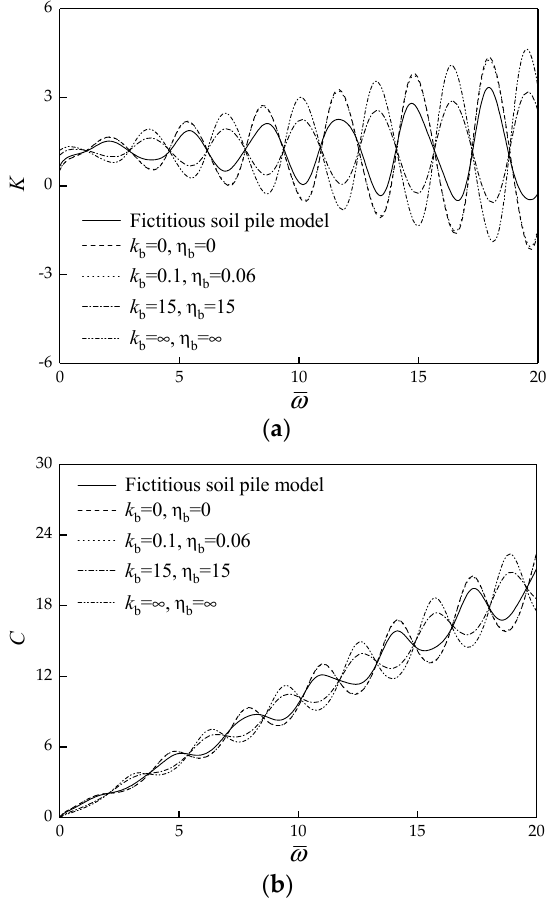
Figure 2. Comparison of FSP model with other models. ( a ) Dynamic stiffness curves; ( b ) Dynamic damping curves.